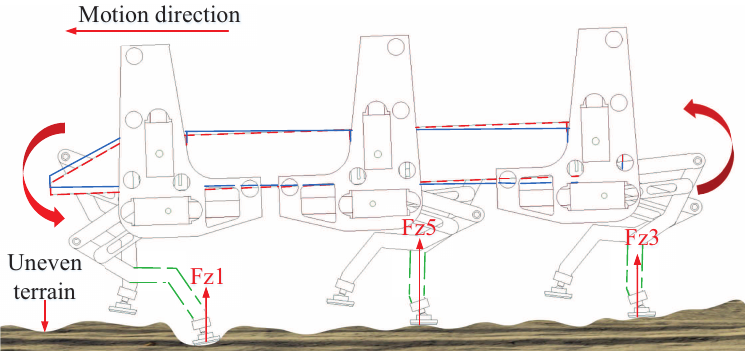
Figure 4. The robot body attitude change under unpredictable motion